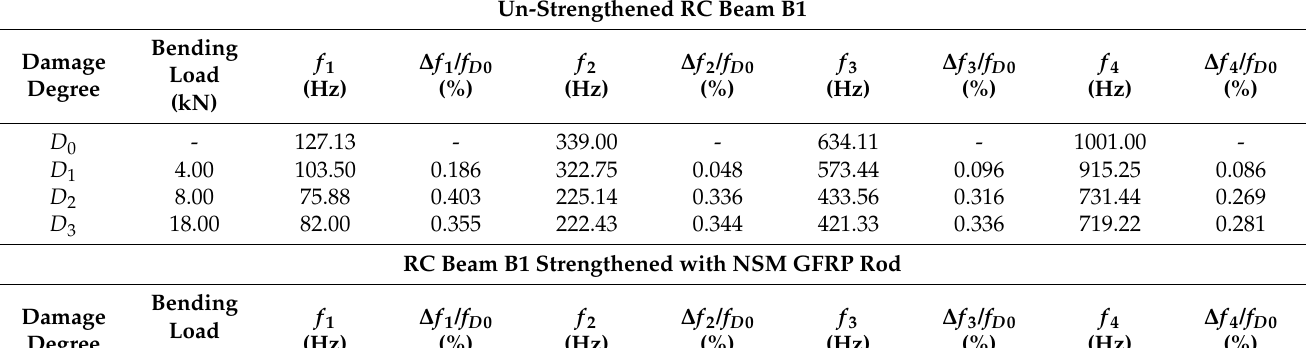
Table 3. Experimental frequency values at different damage degrees D i for each